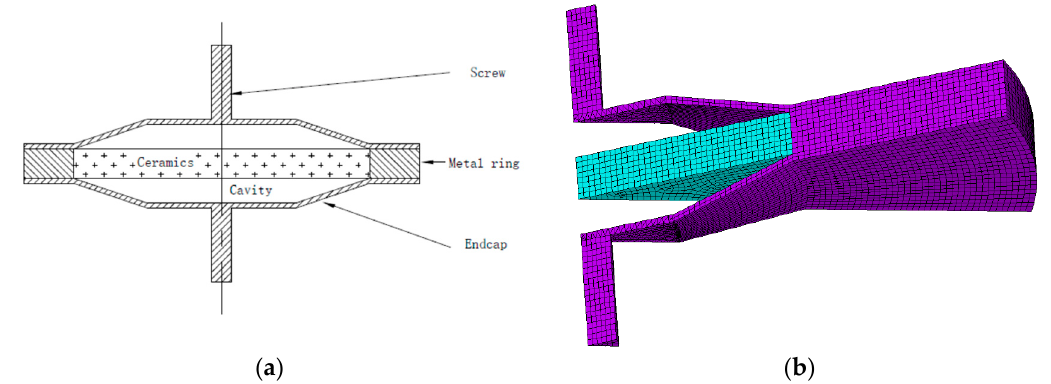
Figure 3. PTA structure and its mesh. ( a ) PTA geometry. ( b ) PTA mesh in simulations.